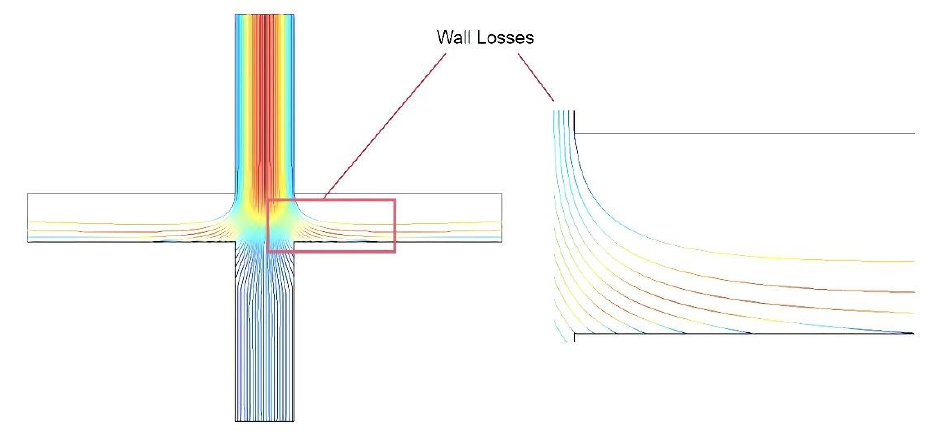
Figure 9. Wall loss on the major flow channel.